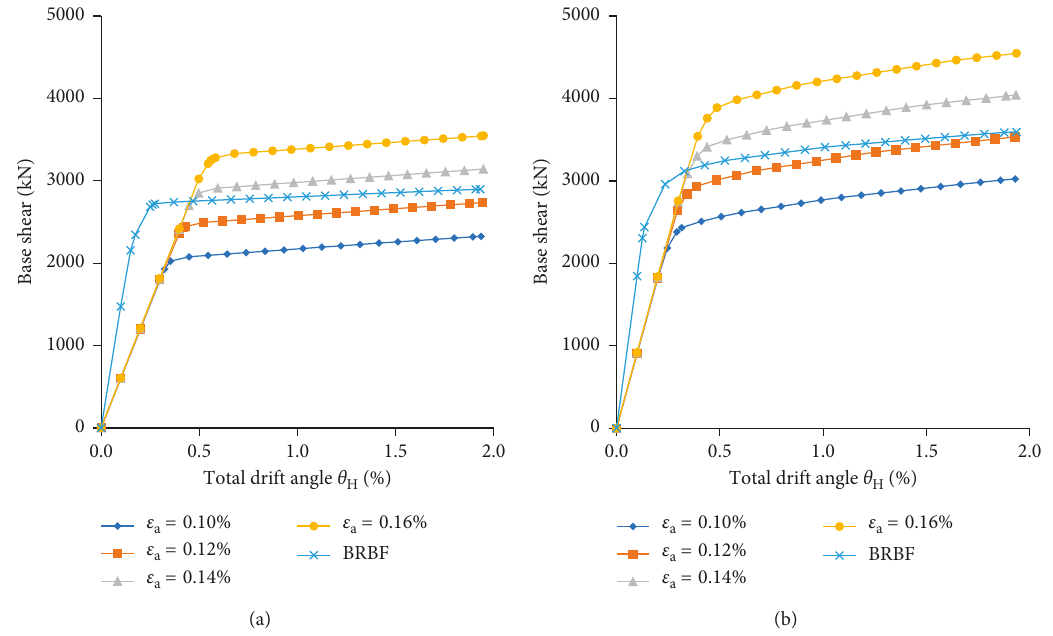
Figure 16: The effects of ε on the base shear response of 9-story SC-TOBFs: (a) LD-1 and (b) a